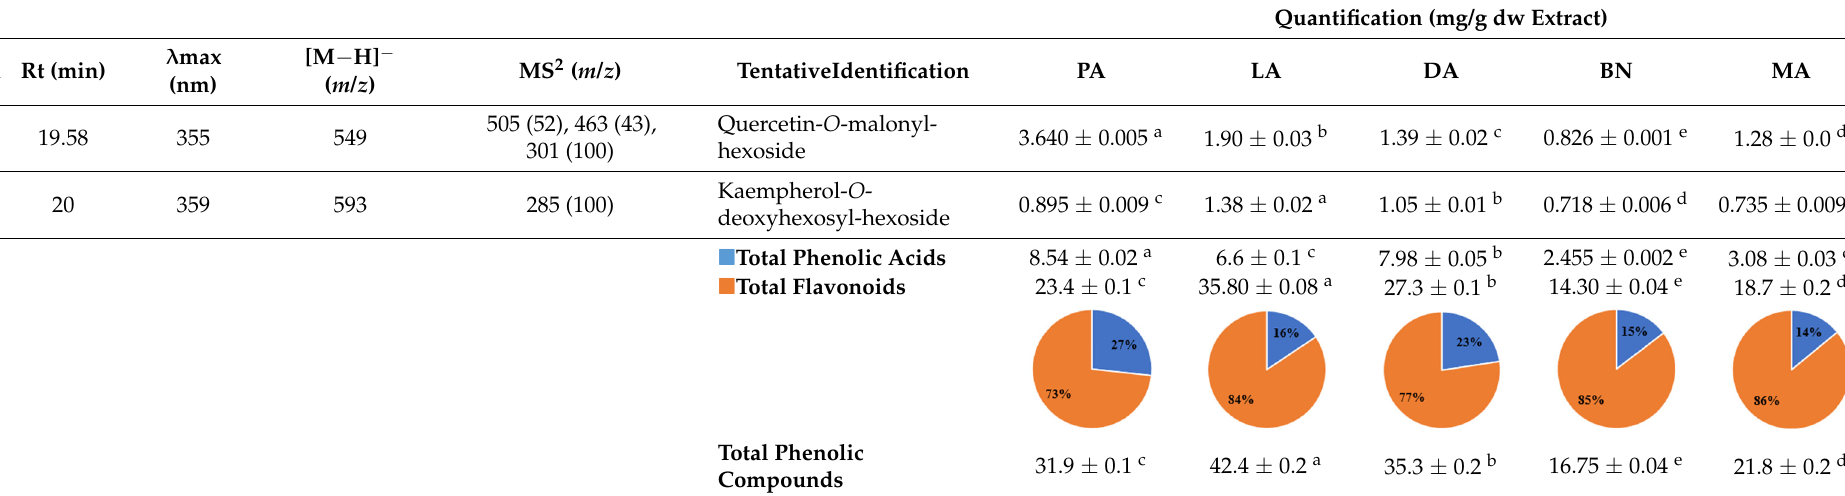
Significant statistical differences in each row (α = 0.05) are represented with different leers. Stand- ard curves used for calibration: apigenin-6- C -glucoside ( y = 197,337 x + 30,036; LOD = 0.19 µg/mL; and LOQ = 0.63 µg/mL, peaks 7 and 8); caffeic acid ( y = 388,345 x + 406,369; LOD = 0.78 µg/mL; and LOQ = 1.97 µg/mL, peak 4); chlorogenic acid ( y = 168,823 x − 161,172; R 2 = 0.9999; LOD = 0.20 µg/mL; and LOQ = 0.68 µg/mL, peaks 1 and 3); luteolin-6- C -glucoside ( y = 4087.1 x + 72,589; R 2 = 0.999; LOD = 0.86 µg/mL; and LOQ = 1.67 µg/mL, peak 9); p -coumaric acid ( y = 301,950 x + 6966.7; LOD = 0.68 µg/mL; and LOQ = 1.61 µg/mL, peak 3); quercetin-3- O -glucoside ( y = 34,843 x − 160,173; R 2 = 0.9998; LOD = 0.21 µg/mL; and LOQ = 0.71 µg/mL, peaks 11, 12, and 13); and vanillic acid ( y = 29,751 x –